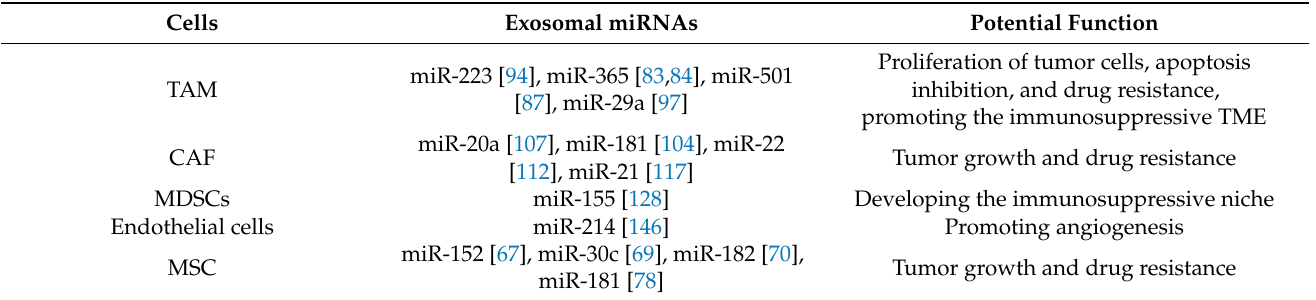
Table 2. The role of exosomal miRNAs and their crosstalk in the development of